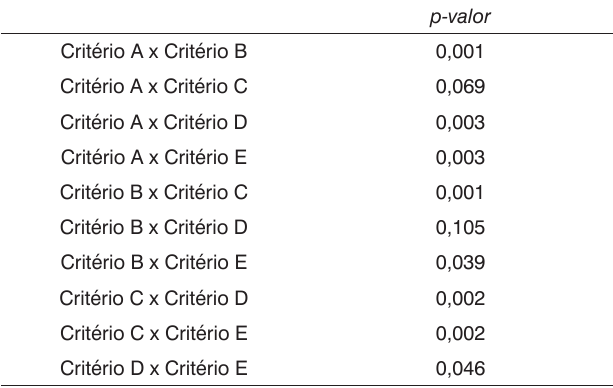
Tabela 2. Comparação dos critérios de recuperação